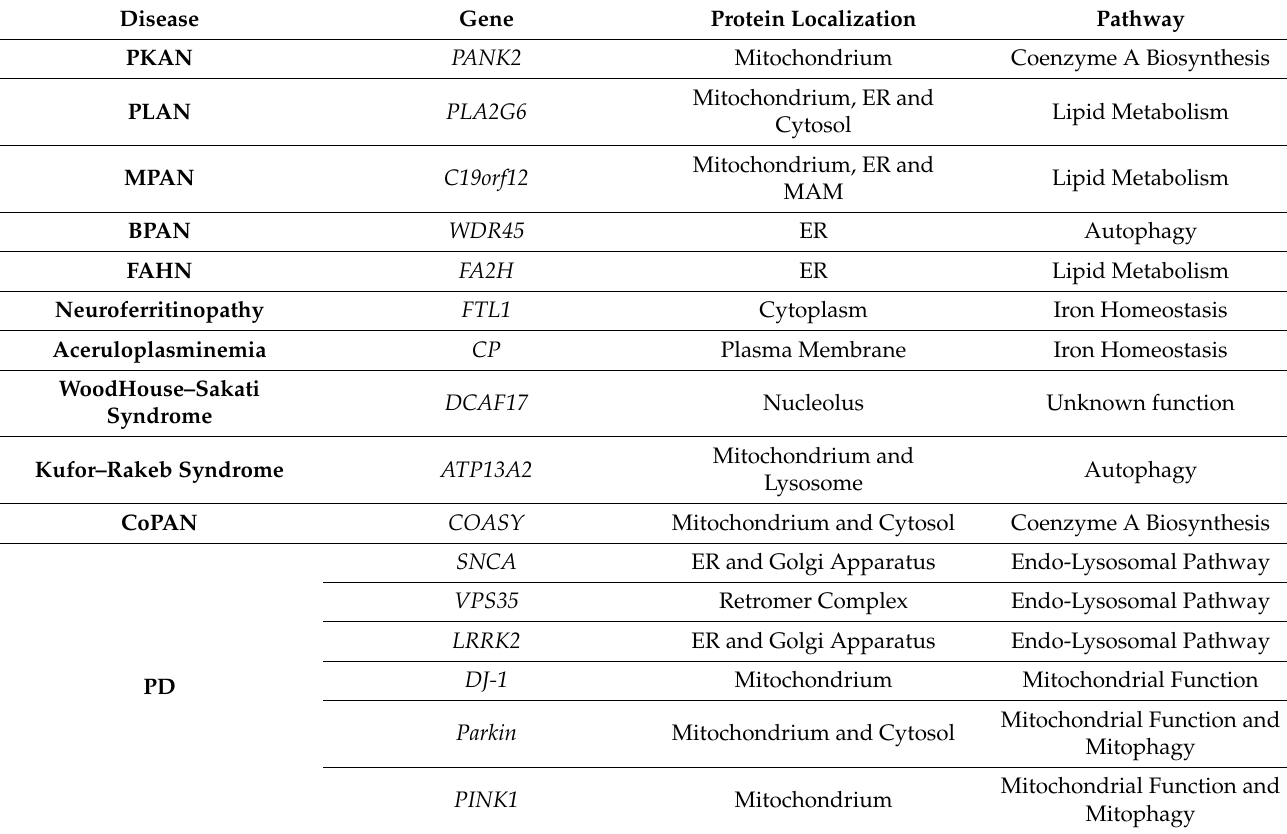
Table 1. Molecular features of PD and NBIA genes. PKAN: pantothenate kinase-associated neurodegeneration; PLAN: PLA2G6-associated neurodegeneration; MPAN: mitochondrial membrane protein-associated neurodegeneration; BPAN: ß-propeller-associated neurodegeneration; FAHN: fatty acid hydroxylase-associated neurodegeneration; CoPAN: COASY protein-associated neurodegeneration; PD: Parkinson’s disease; SNCA: Synuclein Alpha ; VPS35 : vacuolar protein sorting 35 ; LRRK2 : leucine-rich repeat kinase 2 ; PINK1 : PTEN-induced kinase 1 ; ER: endoplasmic reticulum; MAM: mitochondria